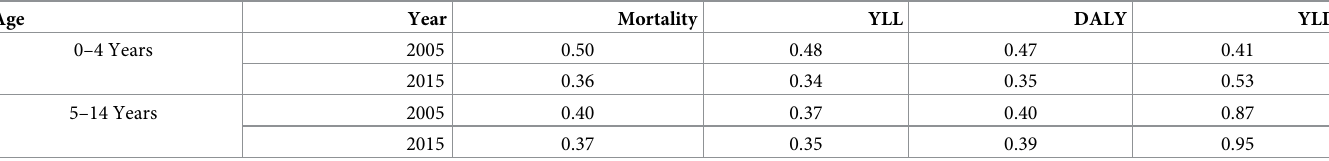
Table 2. Ratio of Global Burden of Disease 2016 over Global Health Estimates 2017 of four indicators of burden of injuries in Ethiopia.